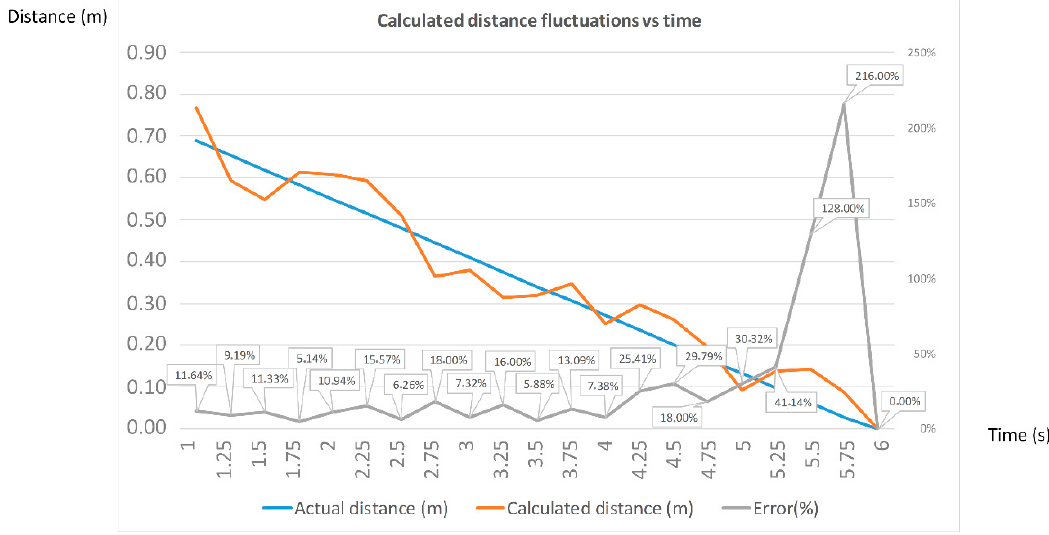
Table 4. Error values for the calculated distances.